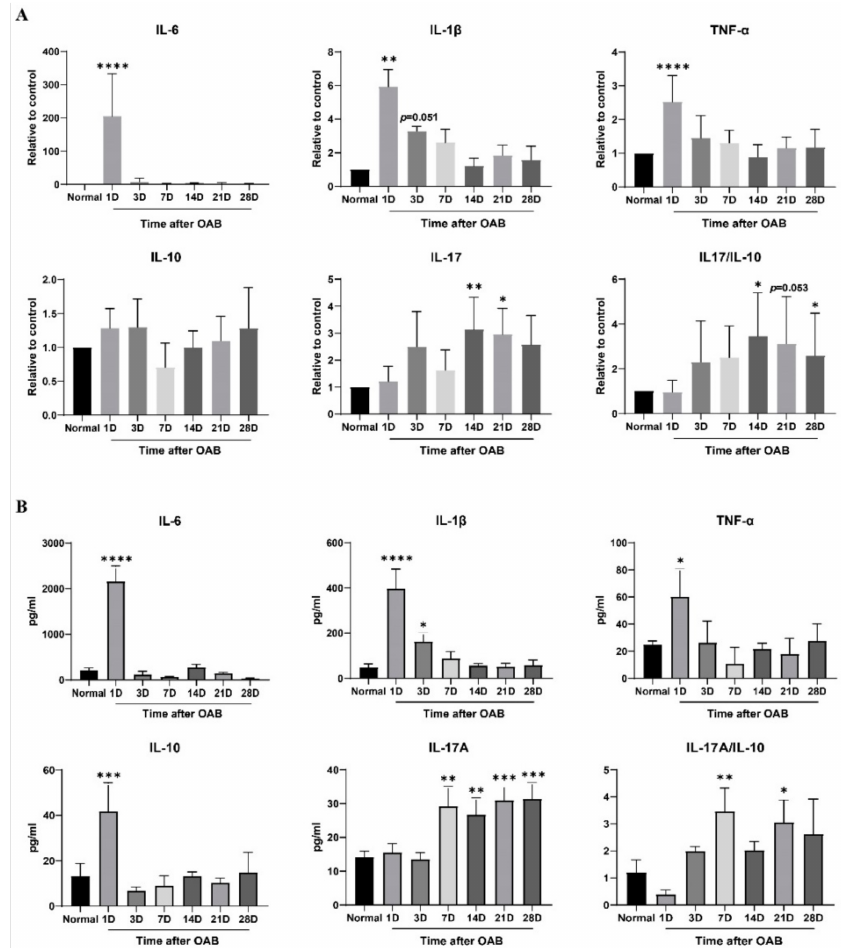
Figure 2. Intraocular levels of IL-1 β , IL-6, TNF- α , IL-10, and IL-17A, and the IL-17A/IL-10 ratio of normal control and OAB subjected eyes. ( A ): mRNA levels of IL-1 β , IL-6, TNF- α , IL-10, and IL-17A, and the IL-17A/IL-10 ratio in the ciliary body of normal control and OAB-subjected eyes on the 1st, 3rd, 7th, 14th, 21st, and 28th day after alkaline exposure. ( B ): Protein expression levels of IL-1 β , IL-6, TNF- α , IL-10, and IL-17A, and the IL-17A/IL-10 ratio in the intraocular fluid of normal control and OAB-subjected eyes at each timepoint. Data are presented as mean ± SD ( n = 6, * p < 0.05, ** p < 0.01, *** p < 0.001, **** p < 0.0001 versus the control